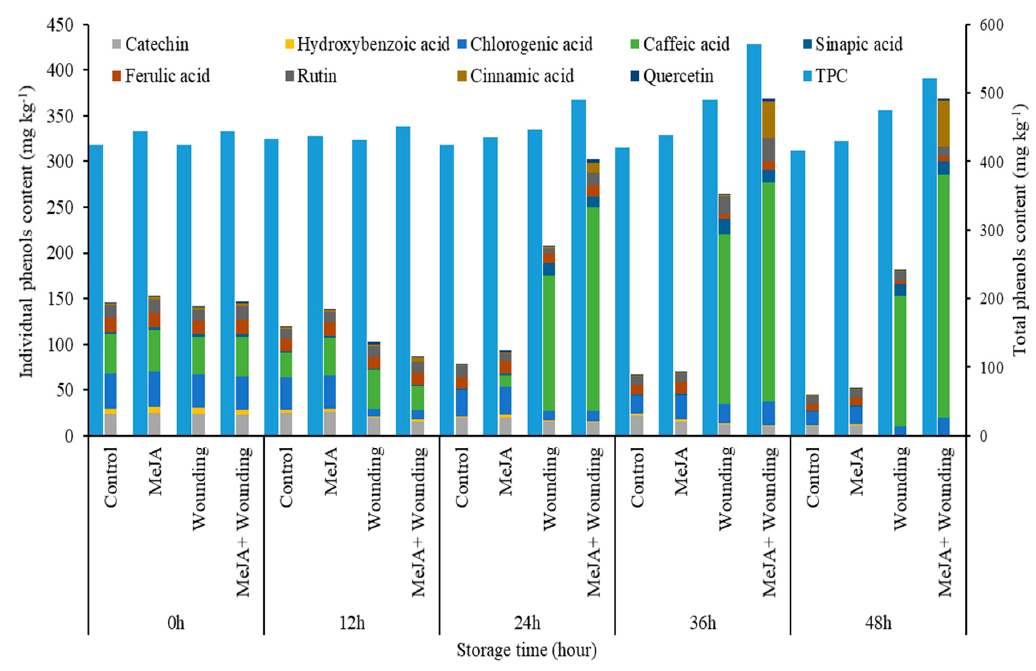
Figure 8. Effect of MeJA treatment and wounding stress on the total amount of individual phenols and TPC of broccoli during 48 h of storage at 20 °C.